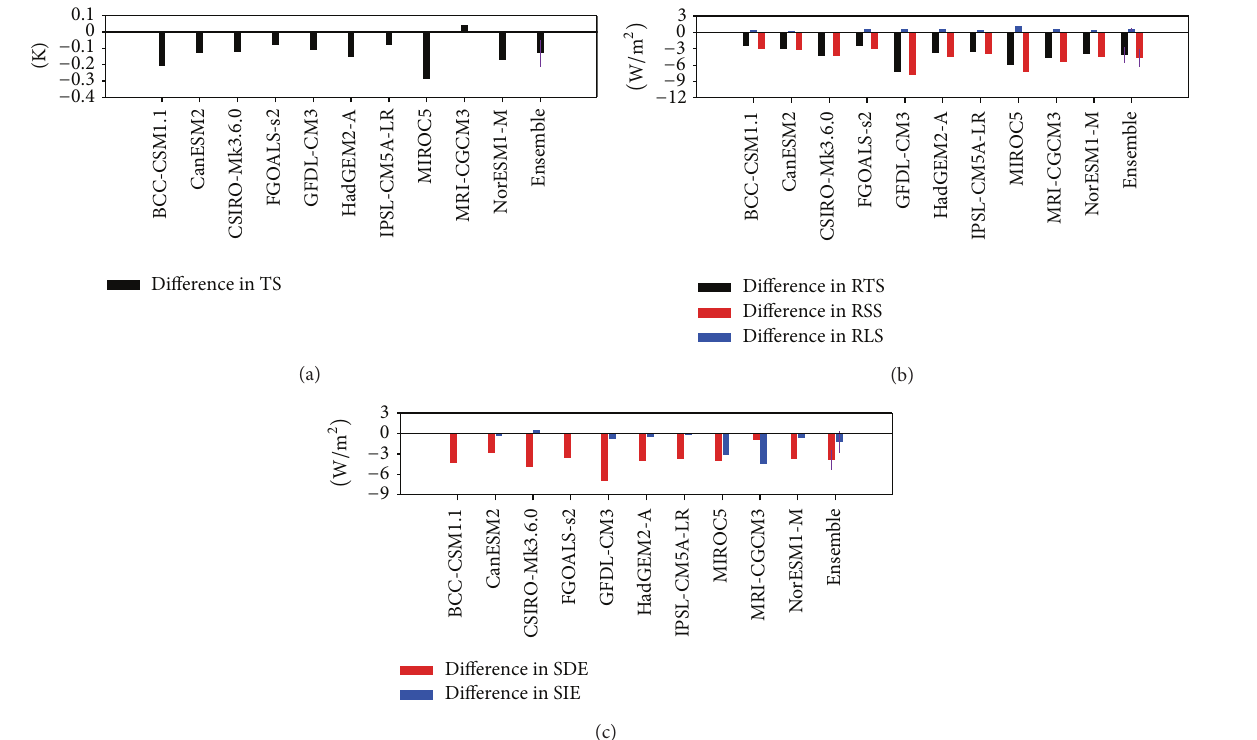
Figure 4: Difference between the aerosol run and CTL run in East China of (a) summer surface (a) temperature; (b) total radiation (black), shortwaveradiation(red),andlongwaveradiation(blue)ofaerosolforcing;and(c)direct(red)andindirect(blue)radiationofaerosolforcing. The far right bar and purple line in each panel are the ensemble mean and standard deviation from all simulations,